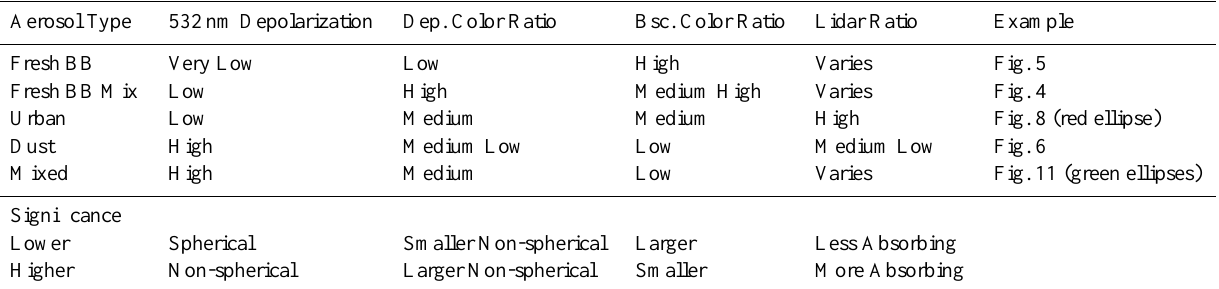
Table 1. HSRL optical properties by aerosol types, along with the significance of high and low values for each property, see text for discussion (BB=Biomass